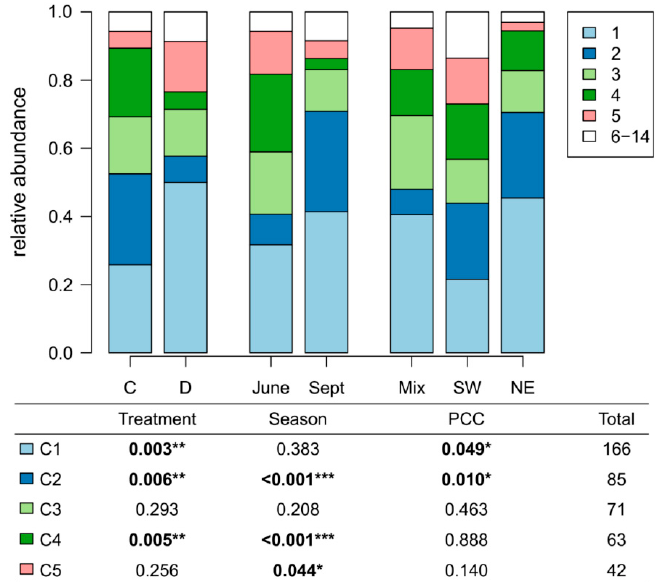
Figure 2. Drought, plant community composition and season influence the 16S rRNA diversity of Pseudomonas commu- nity. Abundances of strains representing fourteen 16S rRNA gene clusters are shown. The clusters 6–14 are grouped due to their low abundance. Five most abundant 16S rRNA gene clusters were closely related to the genes of P. koreensis (cluster C1), P. putida (C2), P. helmanticensis (C3), P. putida (C4, more distant C1) and P. vancouverensis (C5). Significant differences according to the ANOVA test are reported using the following convention: *** p < 0.001, ** p < 0.01, * p < 0.05.